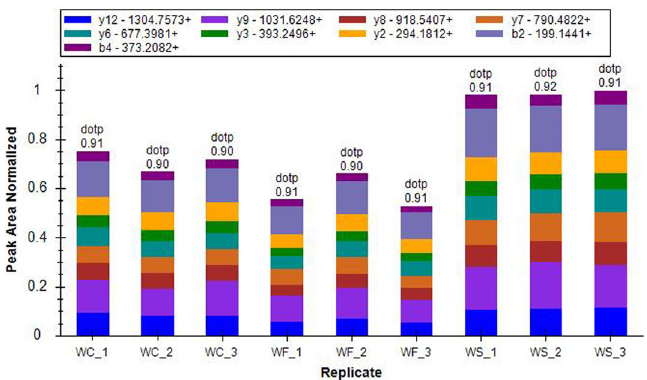
Figure 10. Proteomics verification of the distribution of ion peak area of myosin heavy chain 11 (MYH11) protein in the WC, WF and WS groups. Different colors represented different ion peak areas. In the WF group, the protein levels of MYH11 were significantly decreased. When silybin was added, the protein levels of MYH11 in the WS group increased.